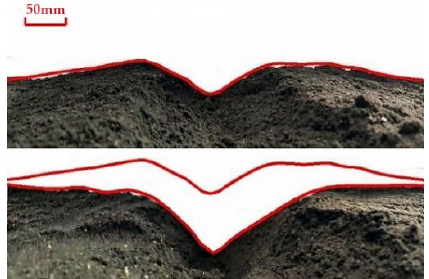
Figure 13. Quantitative method of furrow. Table 7. Equipment model and parameters.